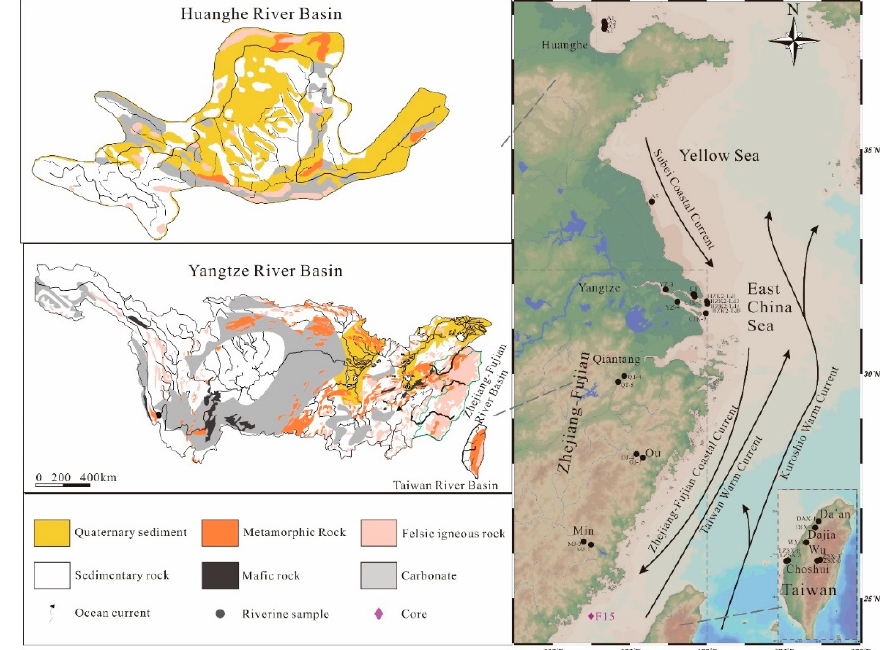
Figure 1. Geological background and sampling locations. The base map is derived from Ocean Data view. The current system is modified from [32]. The geology maps of drainage basins are sourced from [33].